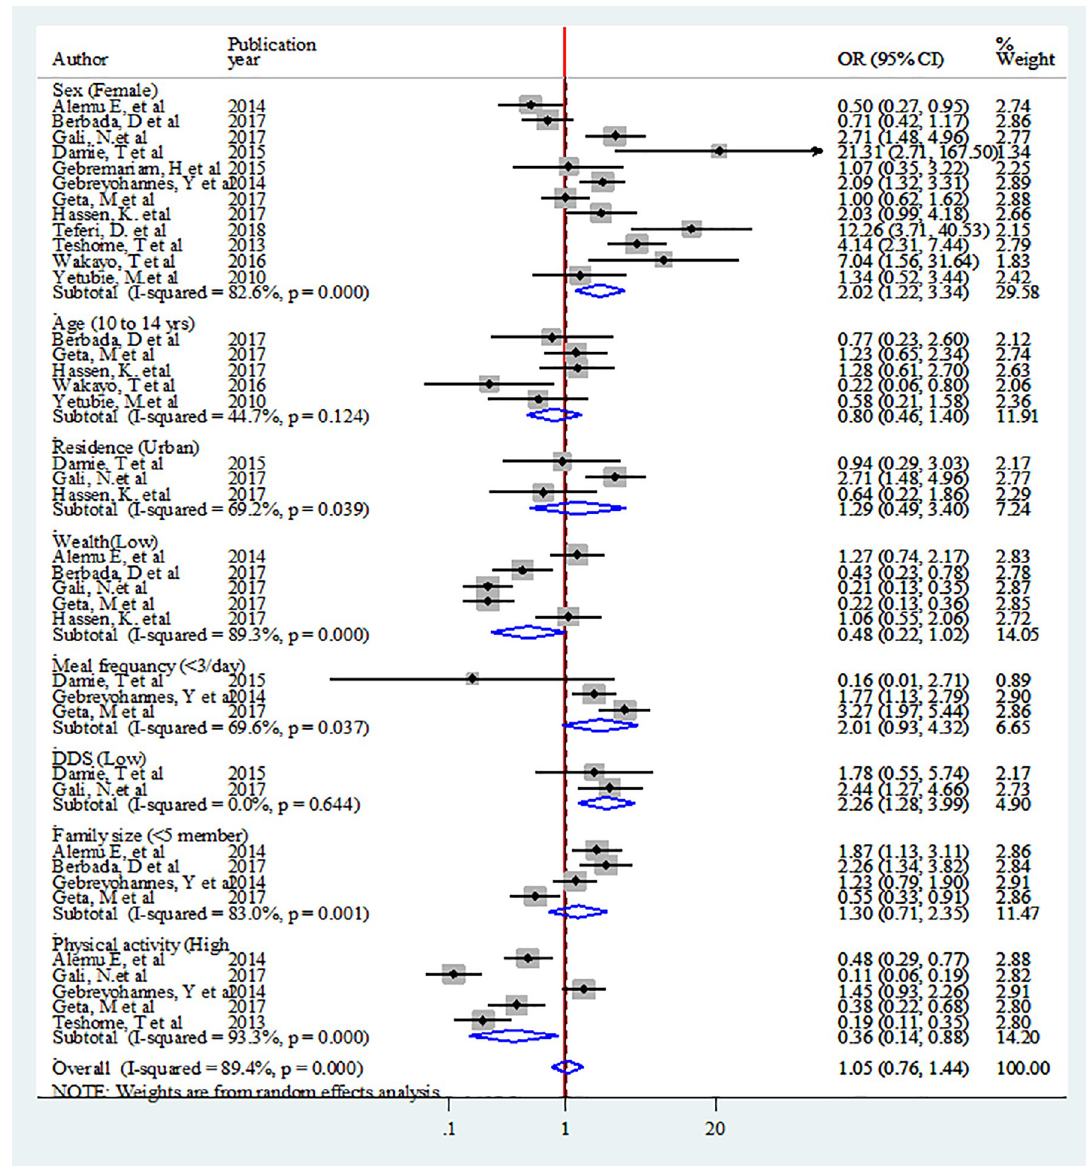
Fig 13. Pooled Odds Ratios of factors associated with overweight/obesity among adolescent in Ethiopia.